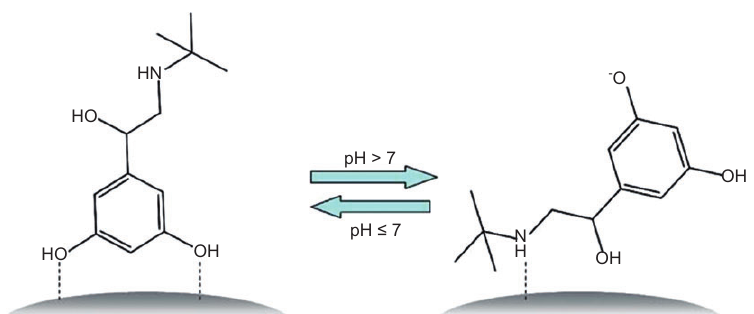
Figure 13 Possible molecular orientation of TB molecules on AuNPs at different pH. Reproduced with permission from: Izquierdo-Lorenzo et al. (2010) . Copyright 2010, American Chemical Society.